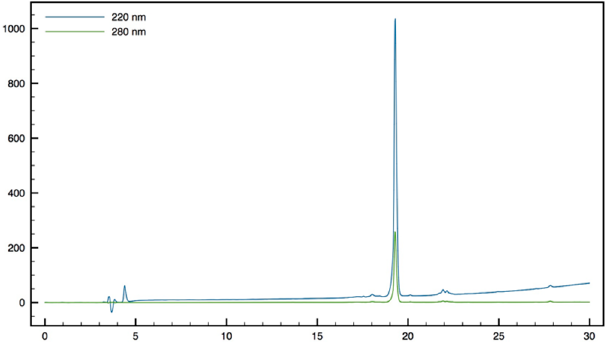
Figure 16. HPLC profile of H- β 3,3 - h -bis-Arg-Tbt-OMe 13 Figure 16 . HPLC profile of H- β 3,3 -h-bis-Arg-Tbt-OMe 13 .